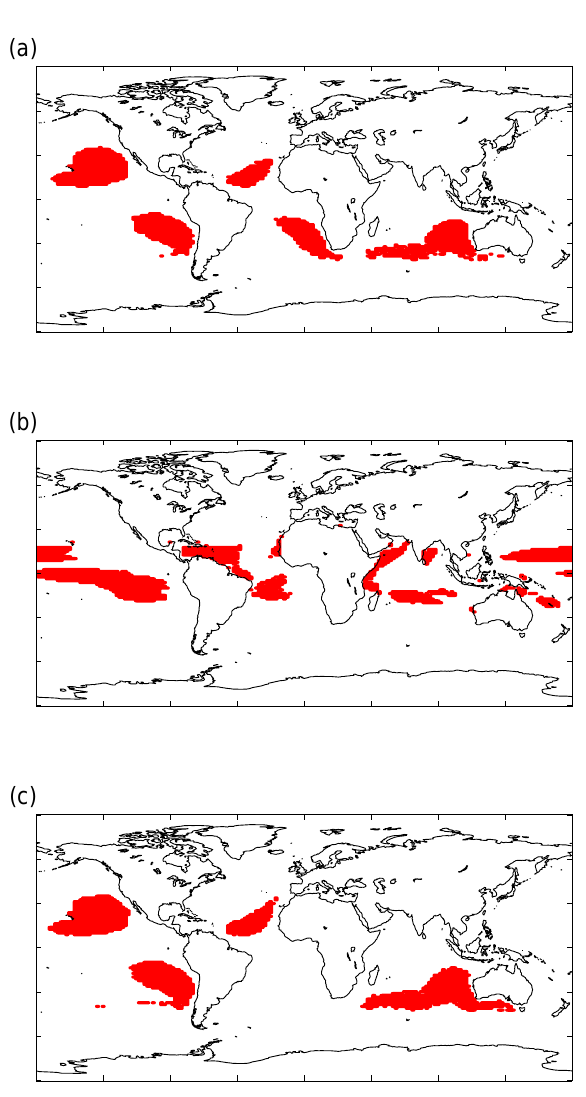
Fig. 1. The three different emission patterns used in this study: (a) I-mask; (b) D-mask; (c) I-mask NSA